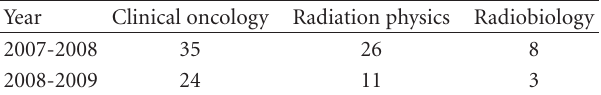
Table 1: Subject-wise data of telemedicine sessions during the years